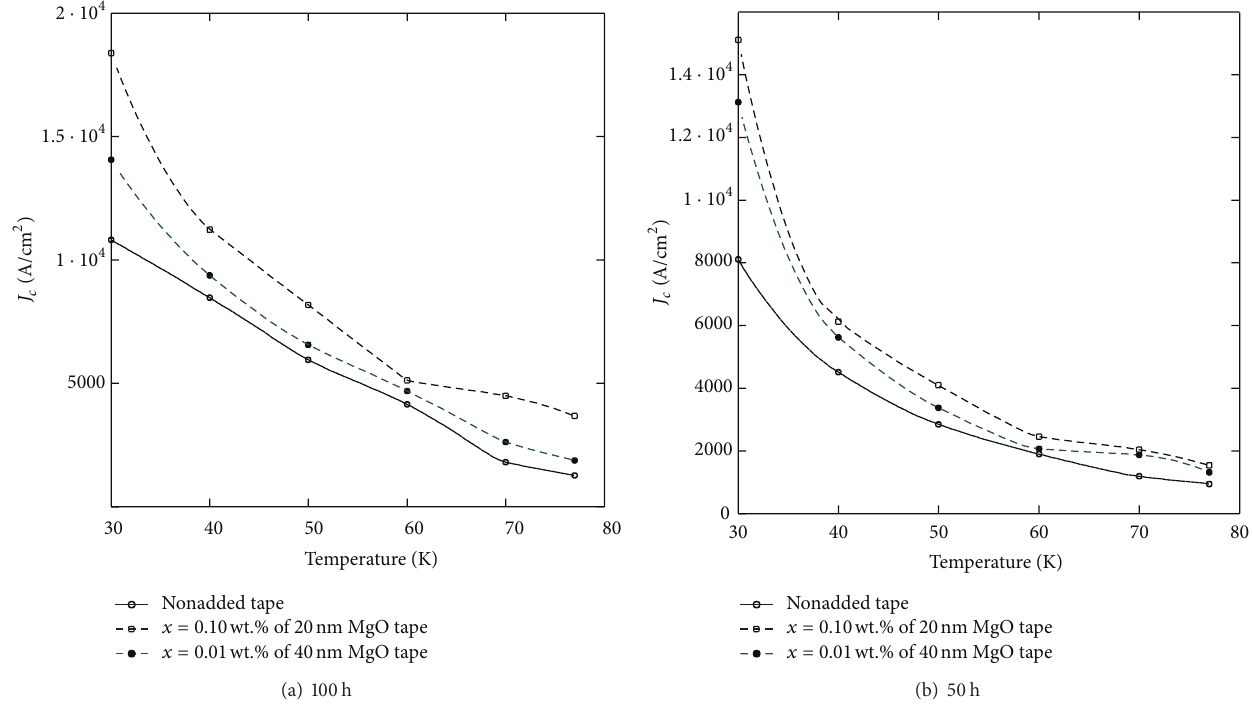
Figure 3: 𝐽 𝑐 of 𝑥 = 0 wt.%, 𝑥 = 0.10 wt.% of 20nm MgO, and 𝑥 = 0.01 wt.% of 40nm MgO tapes sintered for (a) 100h and (b) 50 h as a function of the temperature.